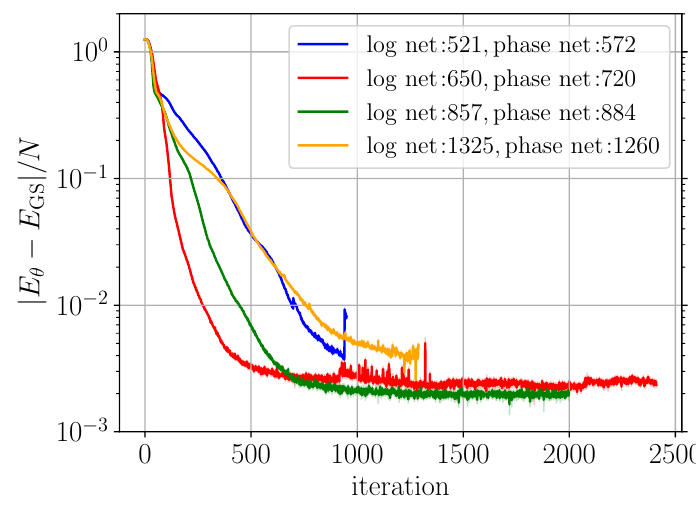
Figure 6: Variational energy density against the iteration number for a fixed neural network layer structure with increasing number of parameters (neurons). The system size is N = 6 × 6. The network architectures used are listed in App. H, and J Optimization was done using RK in combination with SR, see App. A. A total of = 2 15 MC samples were N MC